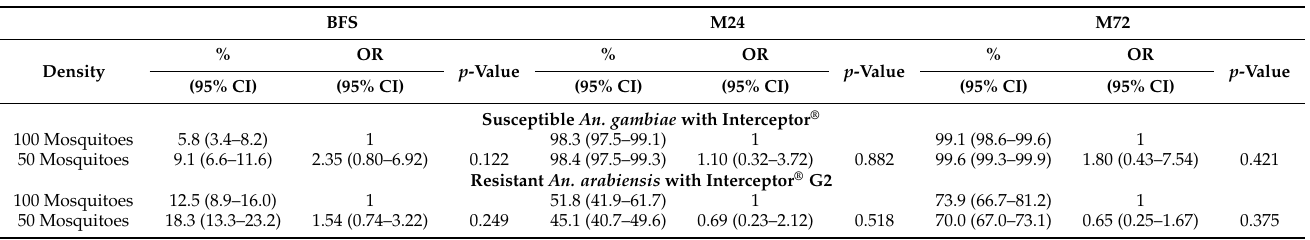
Table 4. Effects of mosquito density on mortality and blood-feeding. The difference in the odds of mosquito mortality at 24 h (M24) or 72 h (M72) and blood feeding success (BFS) for resistant Anopheles arabiensis exposed to Interceptor ® G2 or susceptible Anopheles gambiae to Interceptor ® in the gold standard rabbit-100 and 50-rabbit mosquitoes